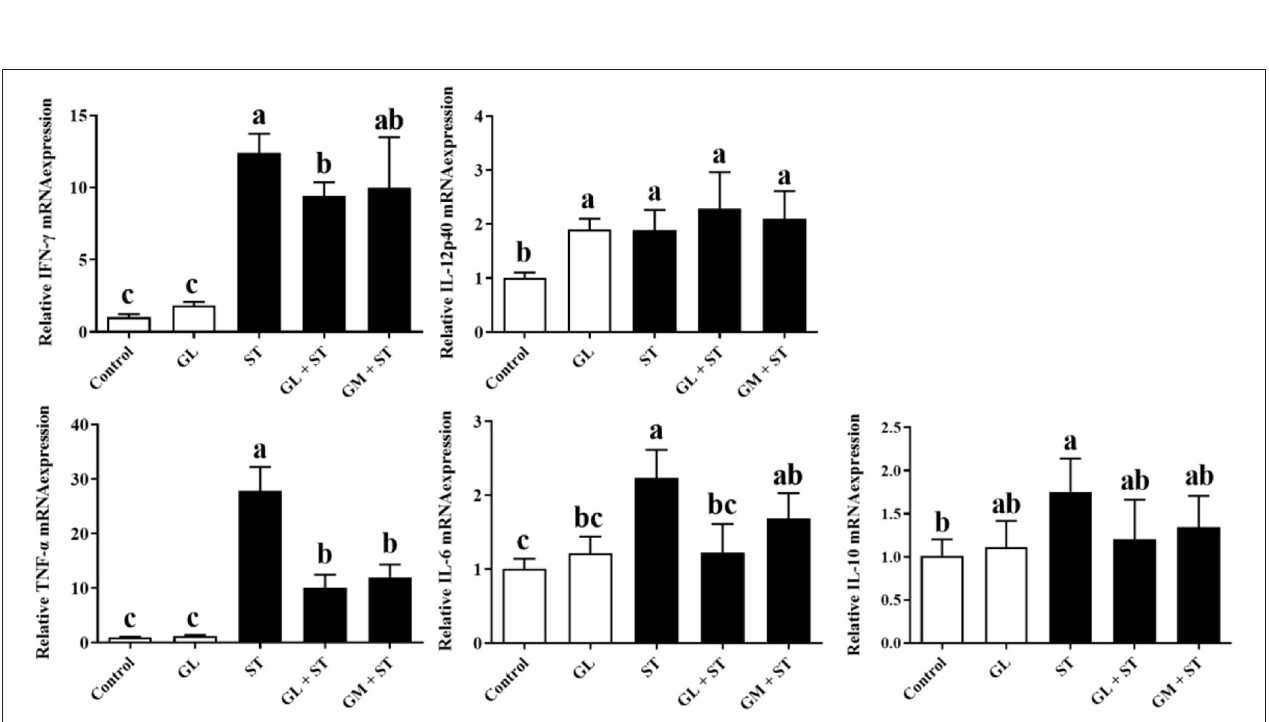
FIGURE 5 | Effect of GL on mRNA expression of liver cytokines in ST-infected mice. The expression of pro-inflammatory cytokine (IFN- γ , IL-12p40, TNF- α , and IL-6) and anti-inflammatory cytokine (IL-10) in liver was measured by RT-qPCR. Results are presented as mean ± SD ( n = 5/group). Different lowercase letters indicate a significant difference ( P <